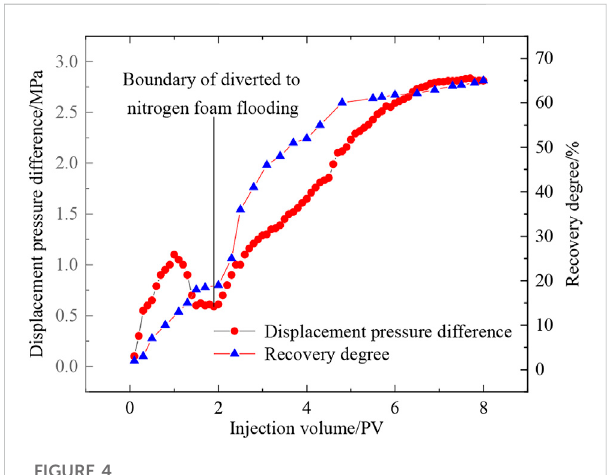
FIGURE 4 Nitrogen foam fl ooding characteristic curves.